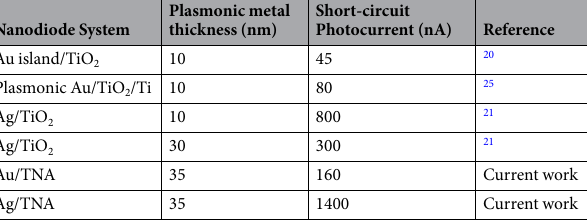
Table 1. Comparision of various plasmonic nanodiode systems with TNA-based nanodiodes in terms of quantum efficiencies and short-circuit